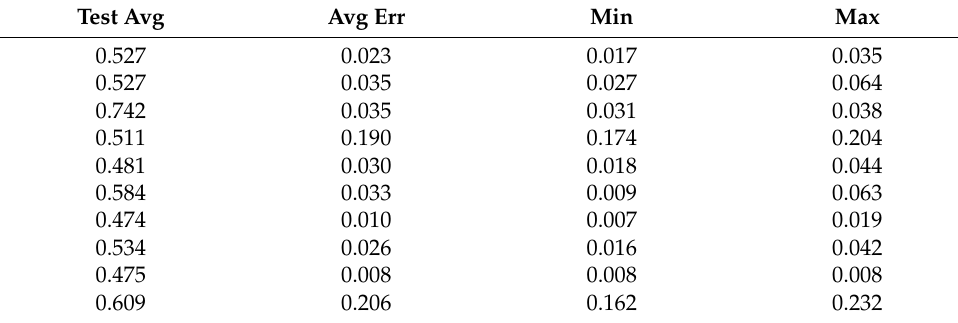
Table A70. Set 1, trials 41–50 data (average actual PR values).